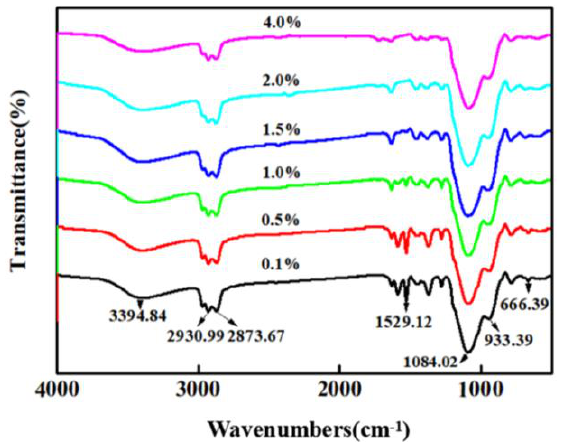
Figure 7. Infrared spectrum of coating with different crosslinking agent content.